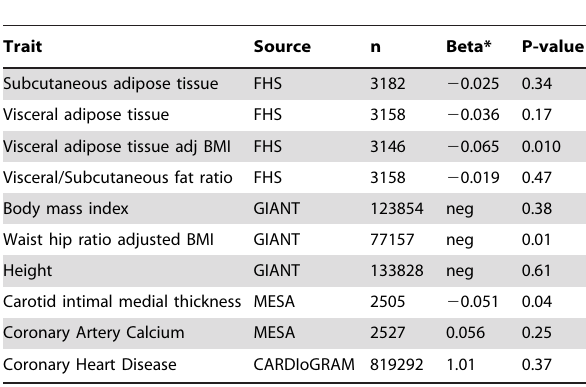
Table 2. Results for rs10198628 across body composition and atherosclerosis traits in the Framingham Heart Study (n=3,158) and the GIANT Consortium (n= 77,157 to 133,828) modeled per copy of the A